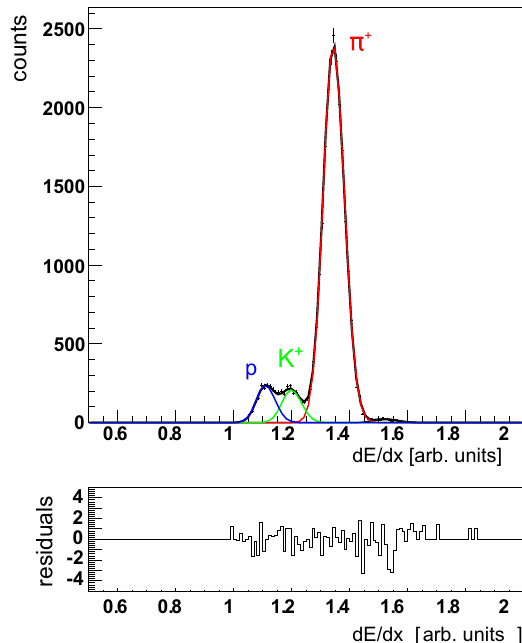
Fig. 5 Thed E / d x distributionsfornegatively( top - lef t )andpositively ( top - right ) charged particles in the bin 12.6 < p lab ≤ 15.8 GeV / c and 0.2 < p T ≤ 0.3 GeV / c produced in p + p interactions at 158 GeV / c . The fit by a sum of contributions from different particle types is shown